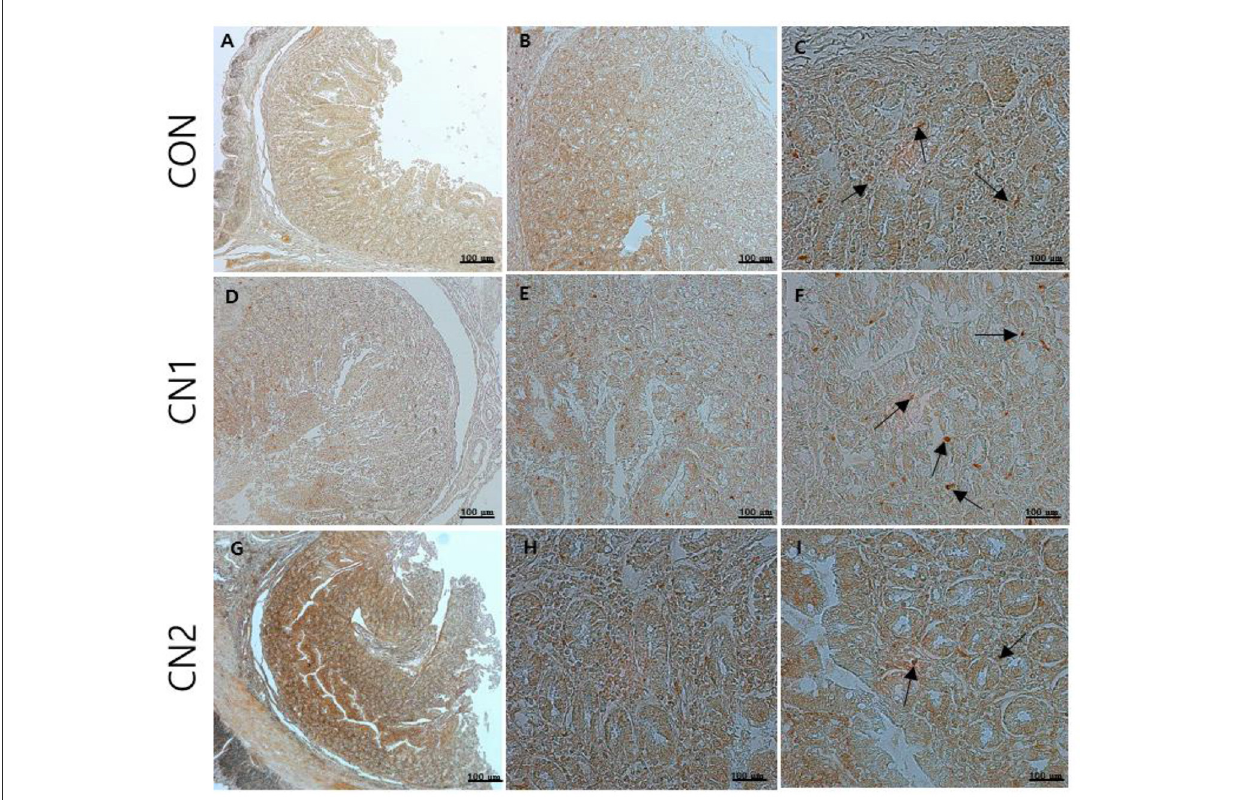
FIGURE3 The immunohistochemical slides for the expressions of immunoglobulin A (IgA) collected from the jejunal sections of small intestine ( n = 6) in finishing pigs fed (A–C) the control (CON) diet wihout curcumin nanospheres (CN); (D–F) the control diet supplemented with CN at 1.0 ml/kg diet (CN1); (G–I) the control diet supplemented with CN at 2.0 ml/kg diet (CN1); The arrow heads represents the intensity of expressions of IgA antibody. The 3,3’-diaminobenzidine (DAB) is used as the substrate for tissue sections staining for viewing using bars 100 µ m at different